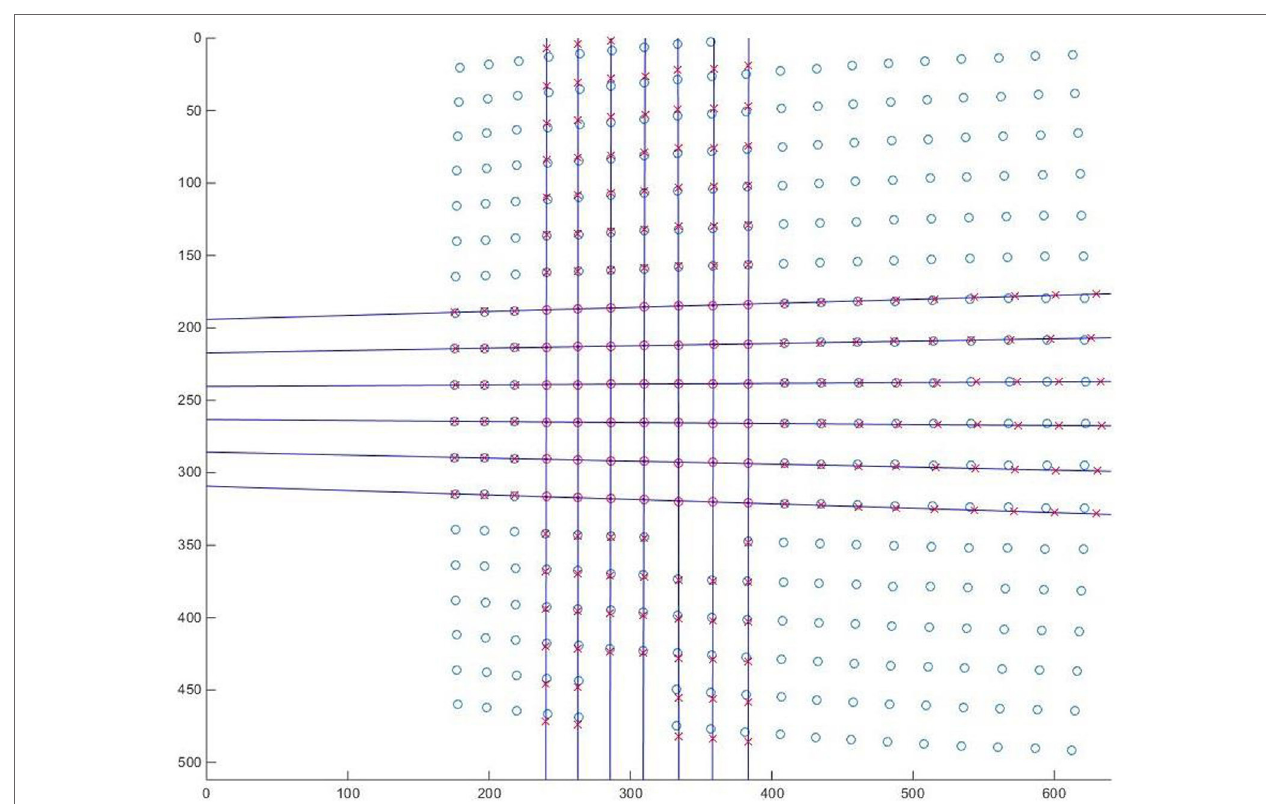
FIgURe 3 | Linear fits through a 7 × 7 marker subset at the center shows the shift between distorted (circles) and corrected (crosses) location of thermal markers. Units correspond to raw image pixel numbers.